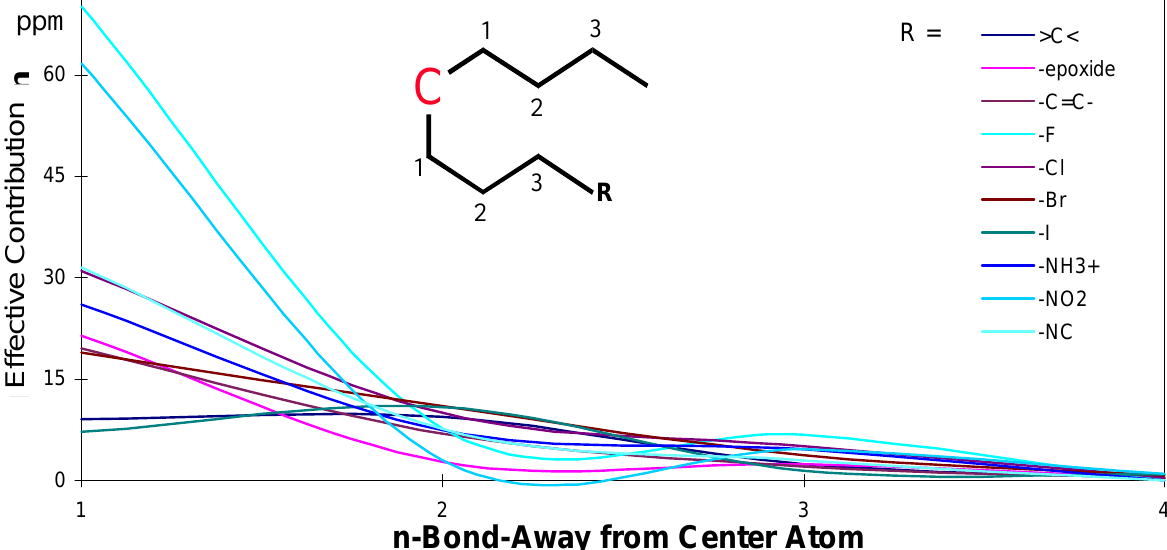
Figure 2. Chemical environment effective contribution to a central carbon atom in an aliphatic